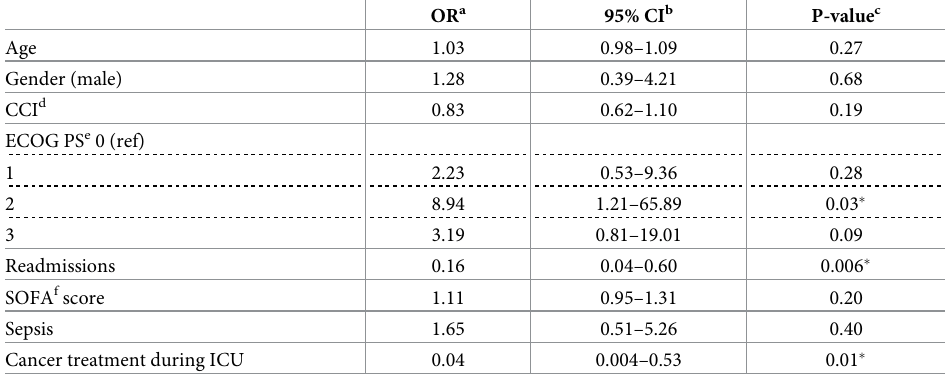
Table 5. Multivariable binary logistic regression analysis study population 2-year